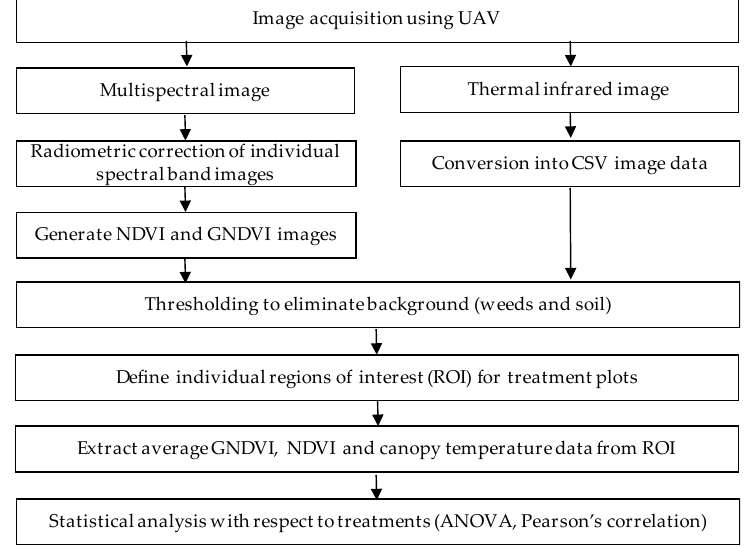
Figure 2. Flowchart describing the key image processing and analysis steps.